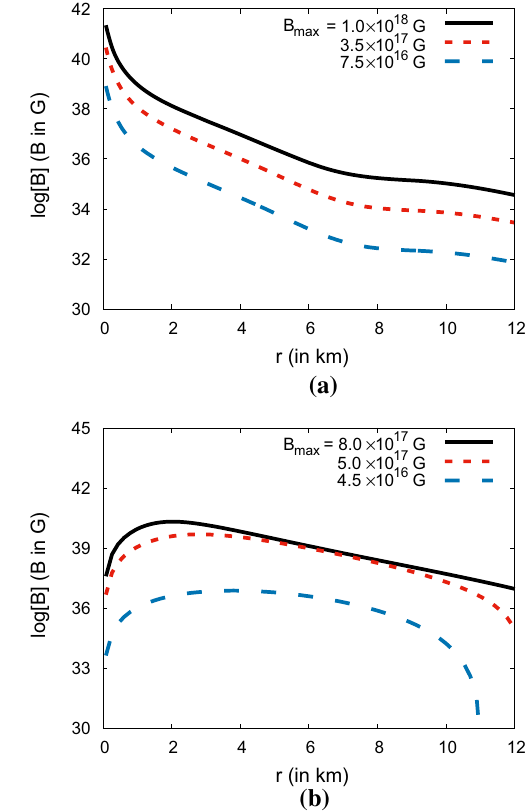
Fig. 3 The magnetic field configuration of the star is shown. Variation of the magnitude of the magnetic field with distance along the equato- rial plane is shown for the poloidal ( a ) and toroidal ( b ) field. Curves are drawn for three different magnetic field strength, the black solid curve for the maximum strength and blue dashed curve for the minimal strength. The logarithmic value of the magnetic field is plotted along the y-axis as the field strength varies from 10 14 G to 10 18 G. The central energy density of star is taken to be 1 . 0 × 10 15 g cm − 3